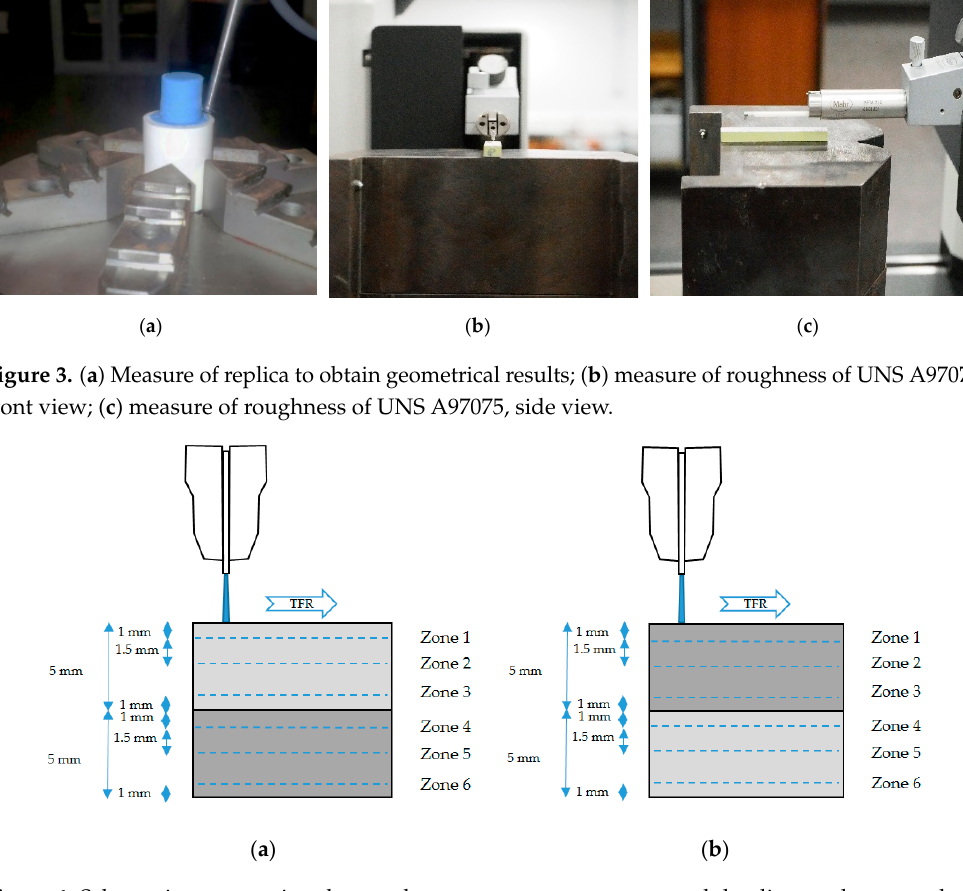
( b ) Figure 6. SOM image of CFRP profile. Test 2. Water pressure (WP) = 2500 bar, traverse feed rating (TFR) = 15 mm/min and abrasive mass flow rate (AMFR) = 340 gr/min for: ( a ) UNS A97075/CFRP; ( b ) CFRP/UNS A97075. ( a ) ( c ) Figure 7. SEM image of CFRP profile. Test 2. WP = 2500 bar, TFR = 15 mm/min and AMFR = 340 gr/min for ( a ) UNS A97075/CFRP; ( b ) CFRP/UNS A97075; ( c ) Abrasive particles in the interface over CFRP. As for aluminum alloy, SOM study showed a series of dark colored streaks along the profile that repeated for both configurations to a greater or lesser extent depending on the energy of the jet. Specifically, Figure 8a shows the marks mentioned at the bottom while Figure 8b at the top. This